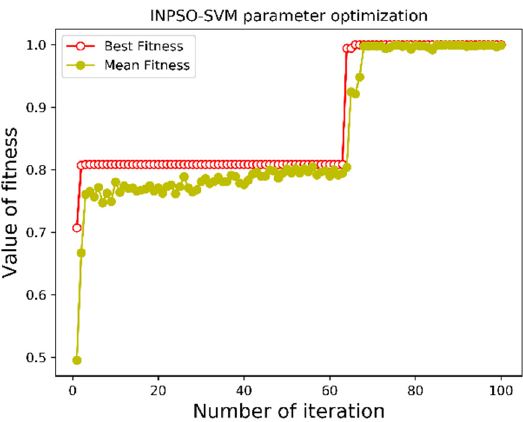
Figure 9. Diagnosis accuracy of INPSO-SVM algorithm.